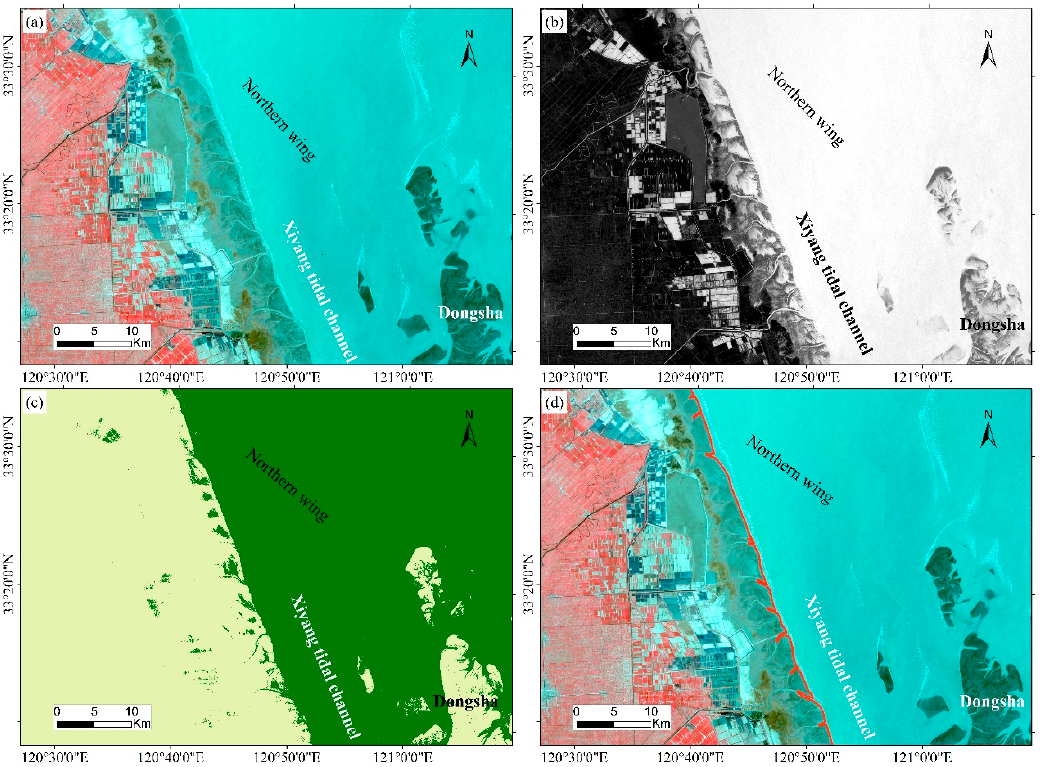
Figure 4. Extraction of the waterline location using normalized differential water body index (NDWI) threshold segmentation ( a ) original image; ( b ) the threshold segmentation result of NDWI; ( c ) NDWI binarization results; ( d ) the final waterline extraction results). Int. J. Environ. Res. Public Health 2020 , 17 , x